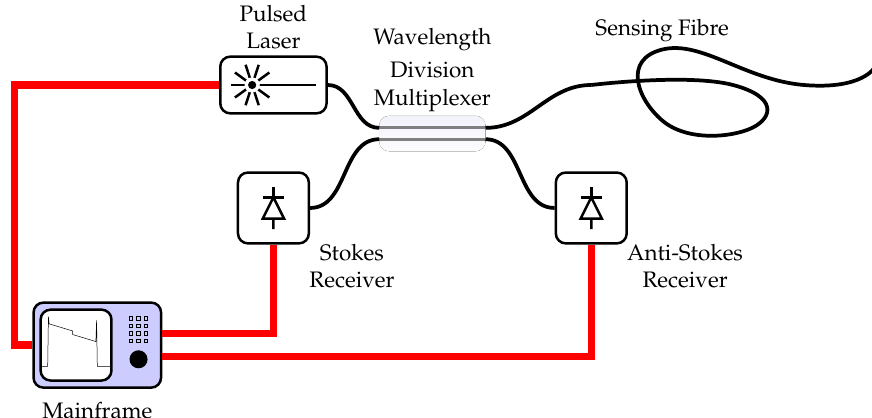
Figure 3. The principle of operation of a Raman-distributed temperature sensor (DTS) exploiting the ratio of the anti-Stokes to the Stokes band intensities detected using an OTDR